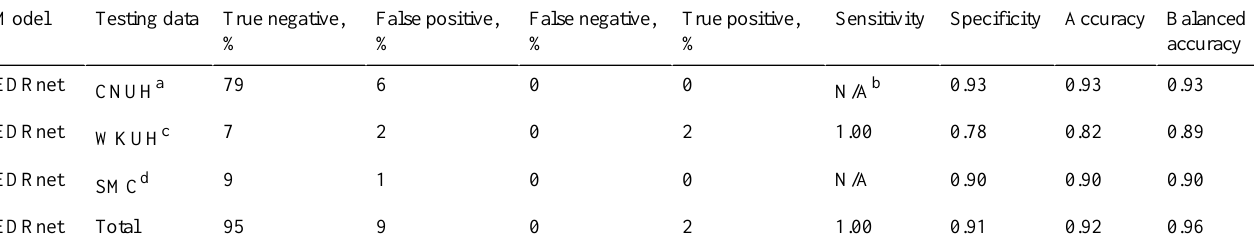
Table 5. Test results from our proposed EDRnet (ensemble learning model based on deep neural network and random forest models) model.